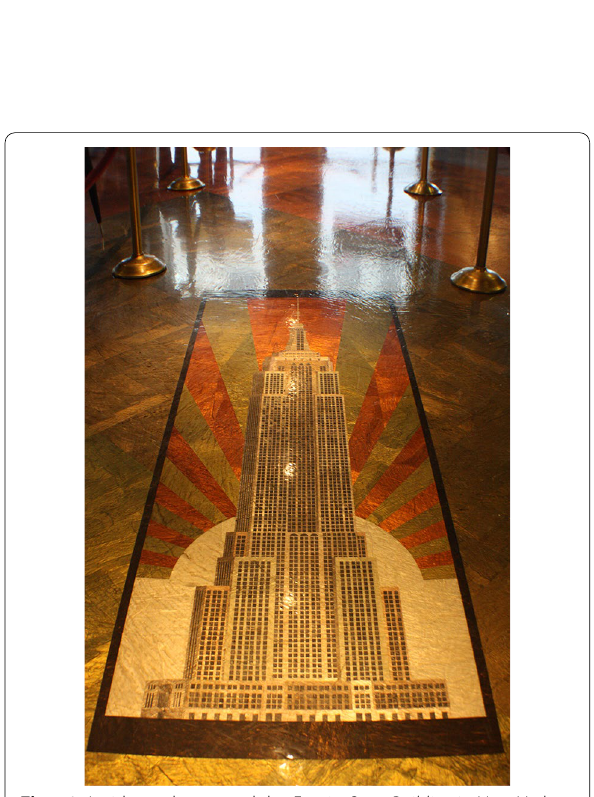
Fig. 19 Inside on the ground the Empire State Building in New York represents